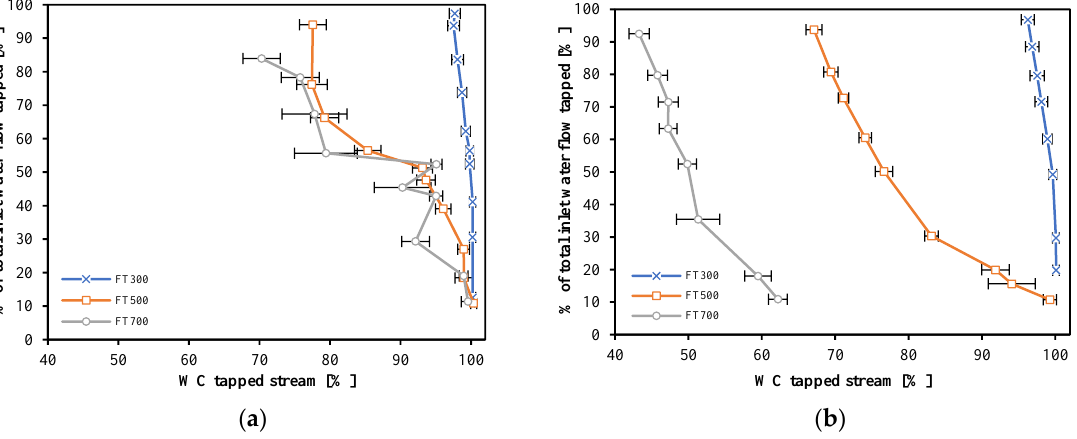
Figure 11. Drainage potential for spiked oil and water and unspiked oil and water with total flow rate of 700 L/min, at WC inlet s ( a ) 30%, ( b ) 50%, and ( c ) 70%. Figures 12 – 15 show drainage potential curves for WC inlet equal to 30%, 50%, 70%, and 90% respectively. Each figure has drainage potential curves for flow rates of 300, 500, and 700 L/min and for unspiked (version a) and spiked crude (version b). The same trend is observed in all figures: higher flow rates are detrimental to drainage potential performance.